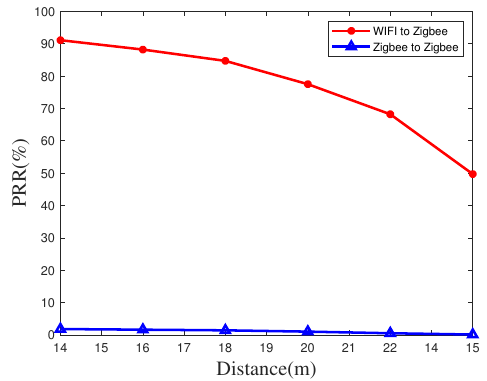
Figure 11. Packet reception rate at long distance indoors.